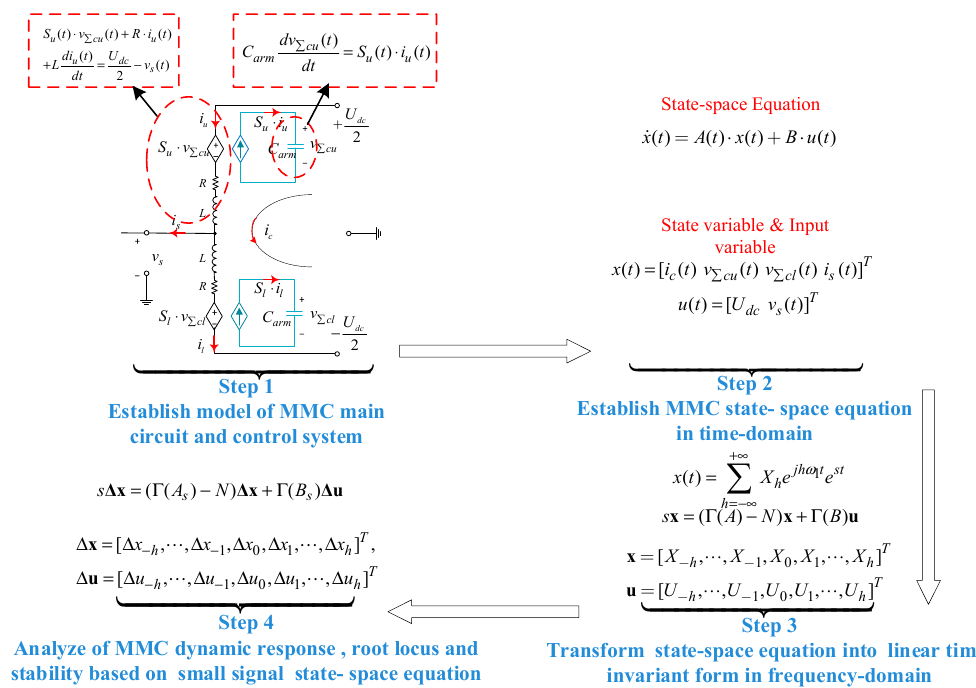
Figure 1. Basic structure of modular multilevel converter (MMC).